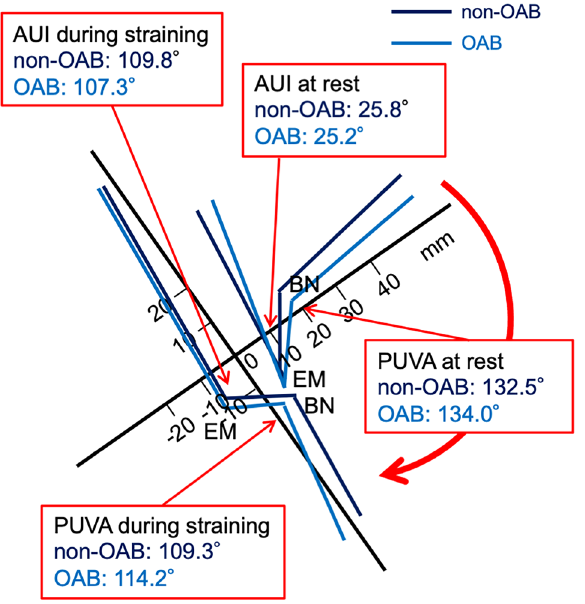
Figure 2. Graphic presentation of mean values (degree) associated with bladder outlet obstruction at rest and during straining in patients with or without overactive bladder (OAB). The sacrococcygeal inferior pubic point line (X-axis) and Y-axis are tilted counterclockwise based on the mean angle in relation to the bottom line on dynamic MRI images; all patients, 35.1° [95% confidence interval (CI) 33.9°, 36.3°]. 0, inferior margin of the symphysis pubis; AUI, angle of urethral inclination BN, bladder neck; EM, external urethral meatus; PUVA, posterior urethrovesical